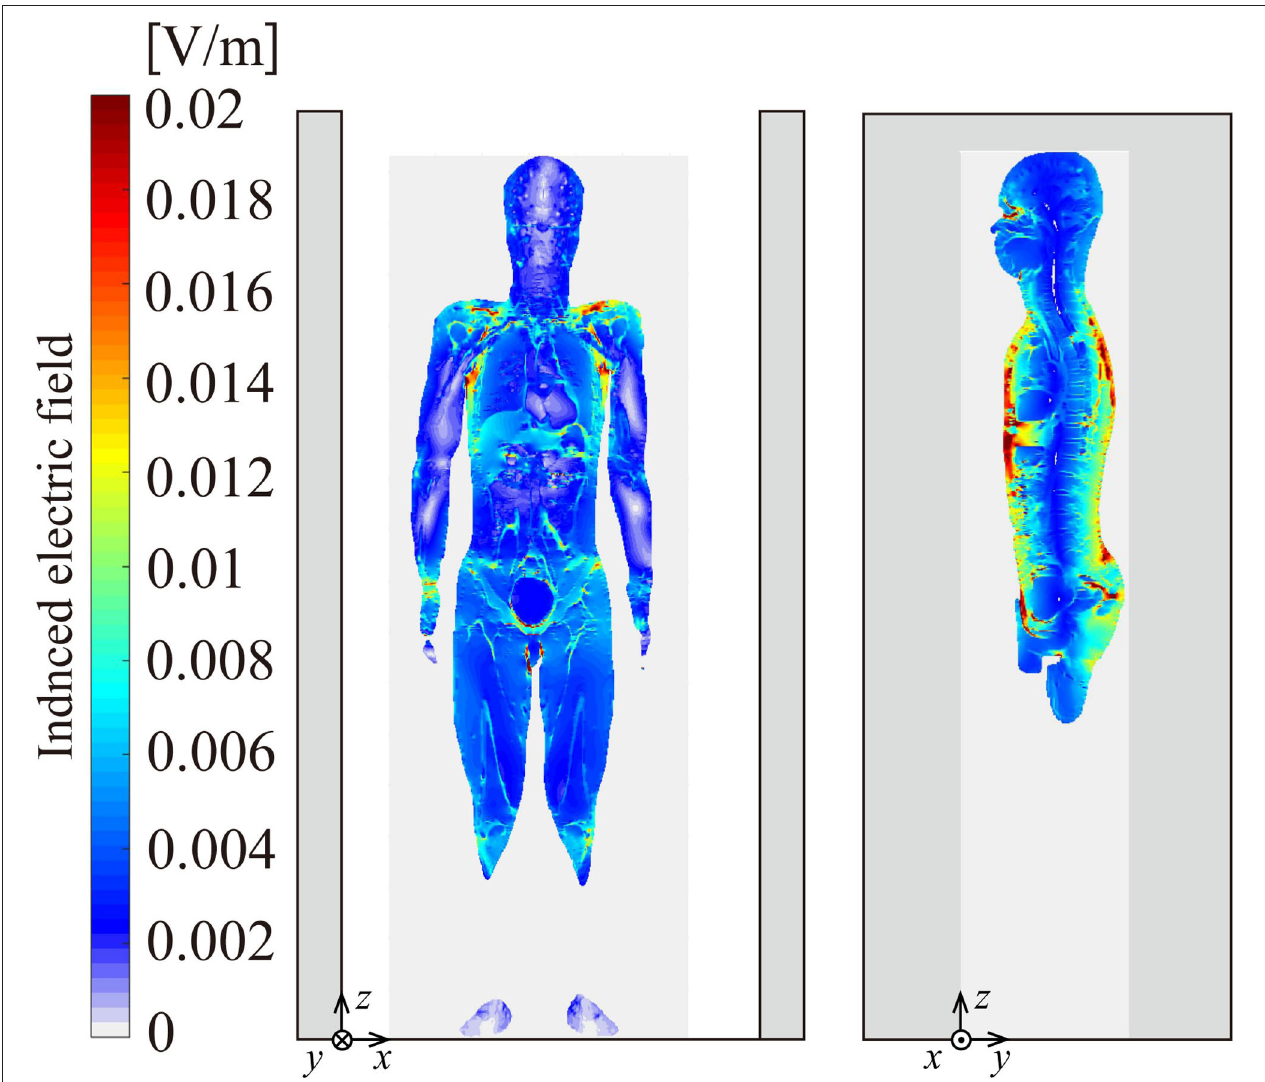
FIGURE 7 | Distribution of induced electric field on the mid-coronal section (left) and the mid-sagittal section (right). The human model is standing in the gate aisle of